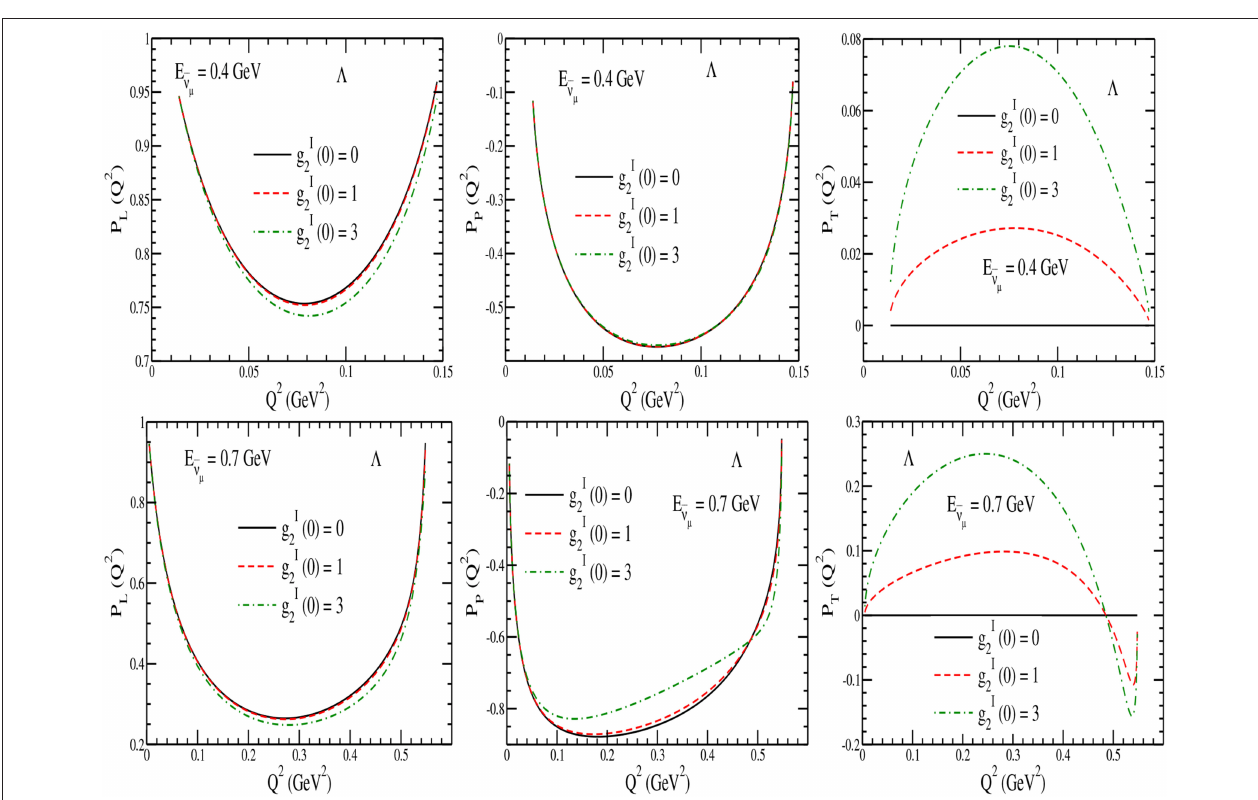
p ν µ µ + 3 at E ν µ = 0.4 GeV (upper) and 0.7 GeV (lower) with g I 2 (0) = ¯ + → + ¯